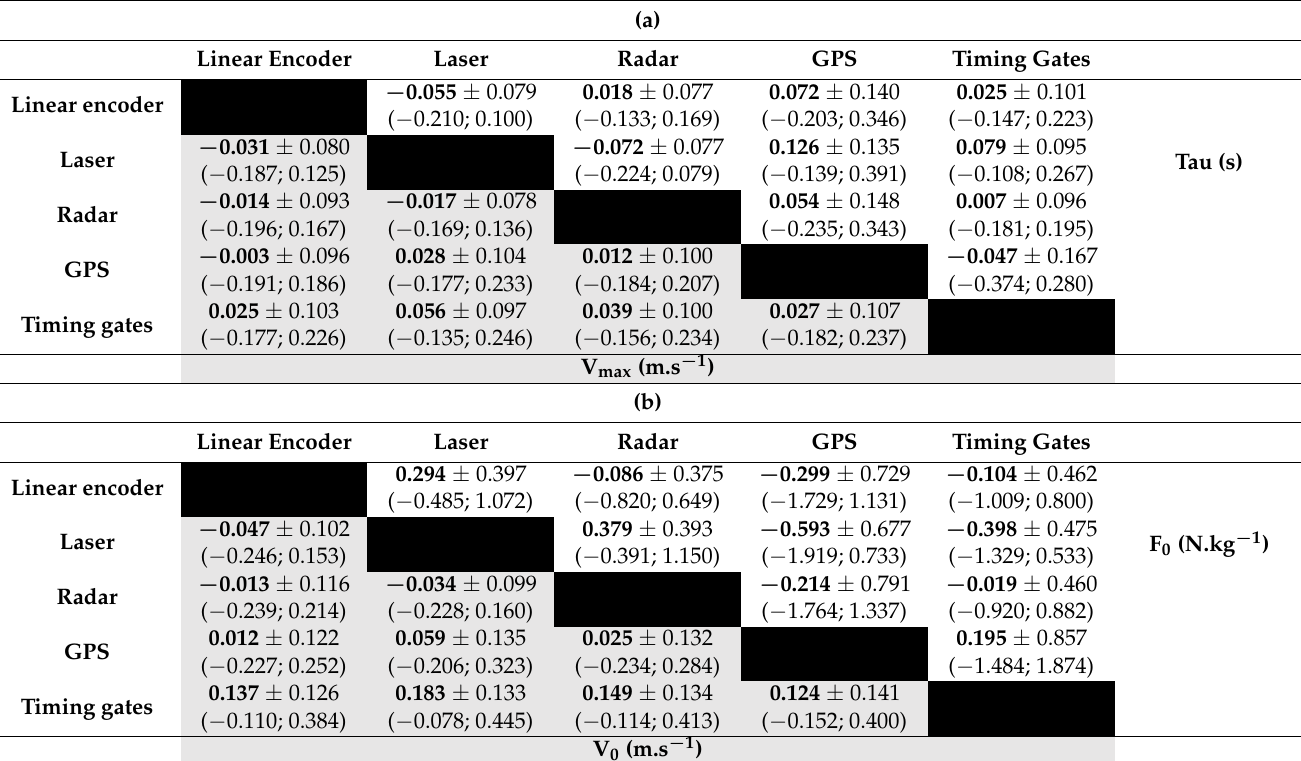
Table 2. ( a ). Mean raw differences (in bold) for two by two comparisons (line vs. column = one comparison) ± SD and associated limits of agreement for all subjects and trials (n = 36) for maximal velocity (V max , lower part of the table, background in grey), acceleration time constant (Tau, upper part, background in white). ( b ). Mean raw differences (in bold) for two by two comparisons (line vs. column = one comparison) ± SD and associated limits of agreement for all subjects and trials (n = 36) for theoretical maximal velocity (V 0 , lower part of the table, background in grey) force and velocity (F 0 , upper part, background in white).